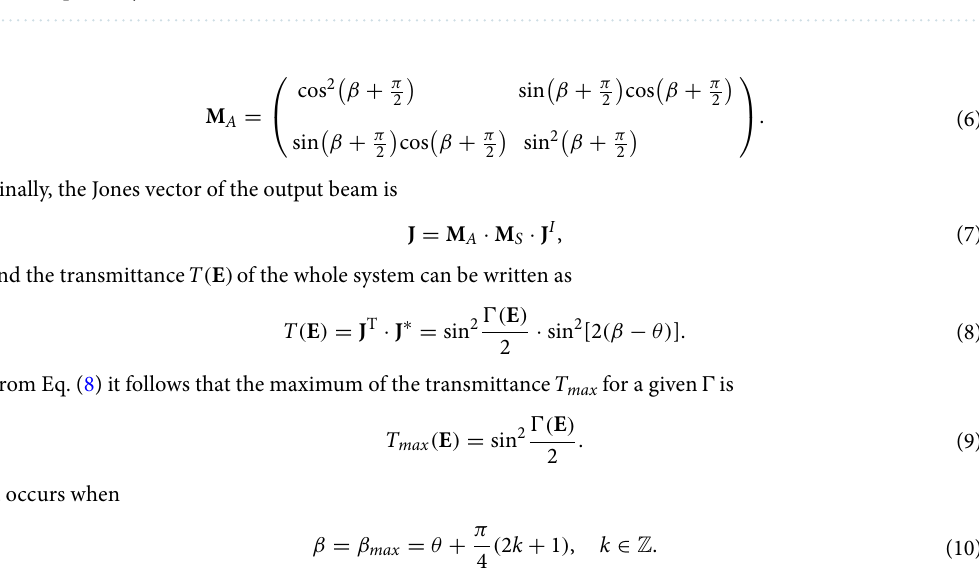
Figure 3. Index ellipsoid ( a ) and detail of its elliptical cut perpendicular to the direction of propagation of the testing light ( b ) represented by its k -vector. The lengths of minor and major semi-axes correspond to n fast and n slow ,